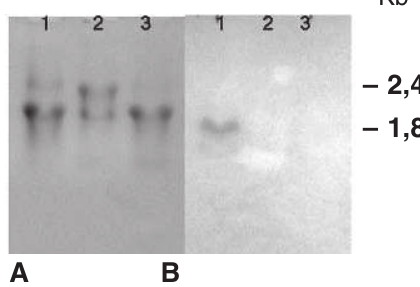
Fig. 3. – Northern Blot analysis with the T1-2D7 probe. Lane 1: total RNA of T. spiralis Ad (40 mg); lane 2: total RNA from mouse M12 cells (40 mg); lane 3: total RNA of T. spiralis ML (40 mg). A: migration of total RNA; B: hybridization to T1-2D7